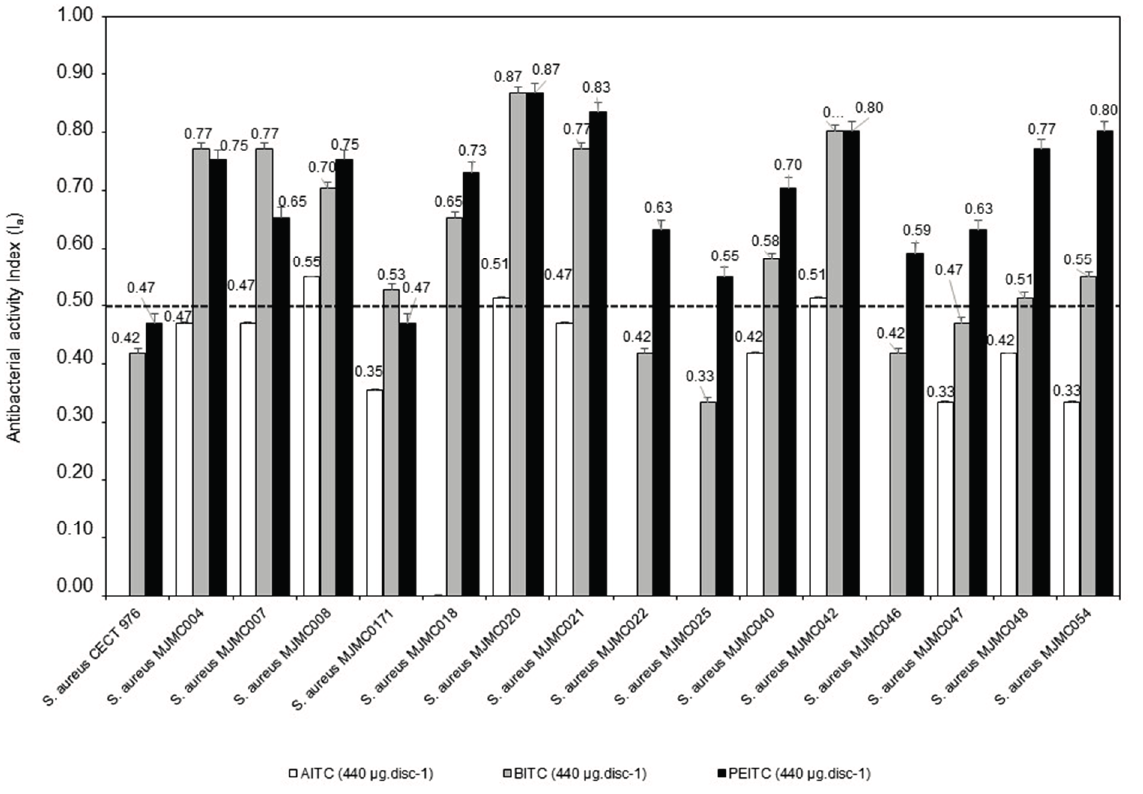
Figure 1. Average levels of the antibacterial index (Ia) for each MRSA isolate and ITCs. Allyl-isothiocyanate (AITC); Benzyl-isothiocyanate (BITC); 2-Phenylethyl-isothiocyanate